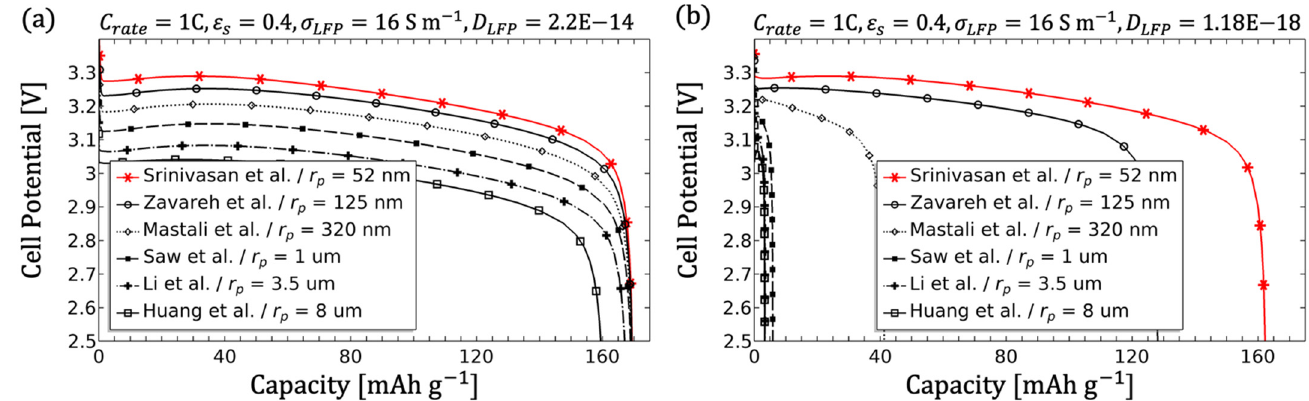
Figure 6. Parameter variation of the particle radius of the LFP electrode: ( a ) the discharge performances with D LFP = 2.2 × 10 − 14 at 1C with an optimised ε s = 0.4 and σ LFP = 16 S m − 1 and ( b ) with D LFP = 1.18 × 10 − 18 .